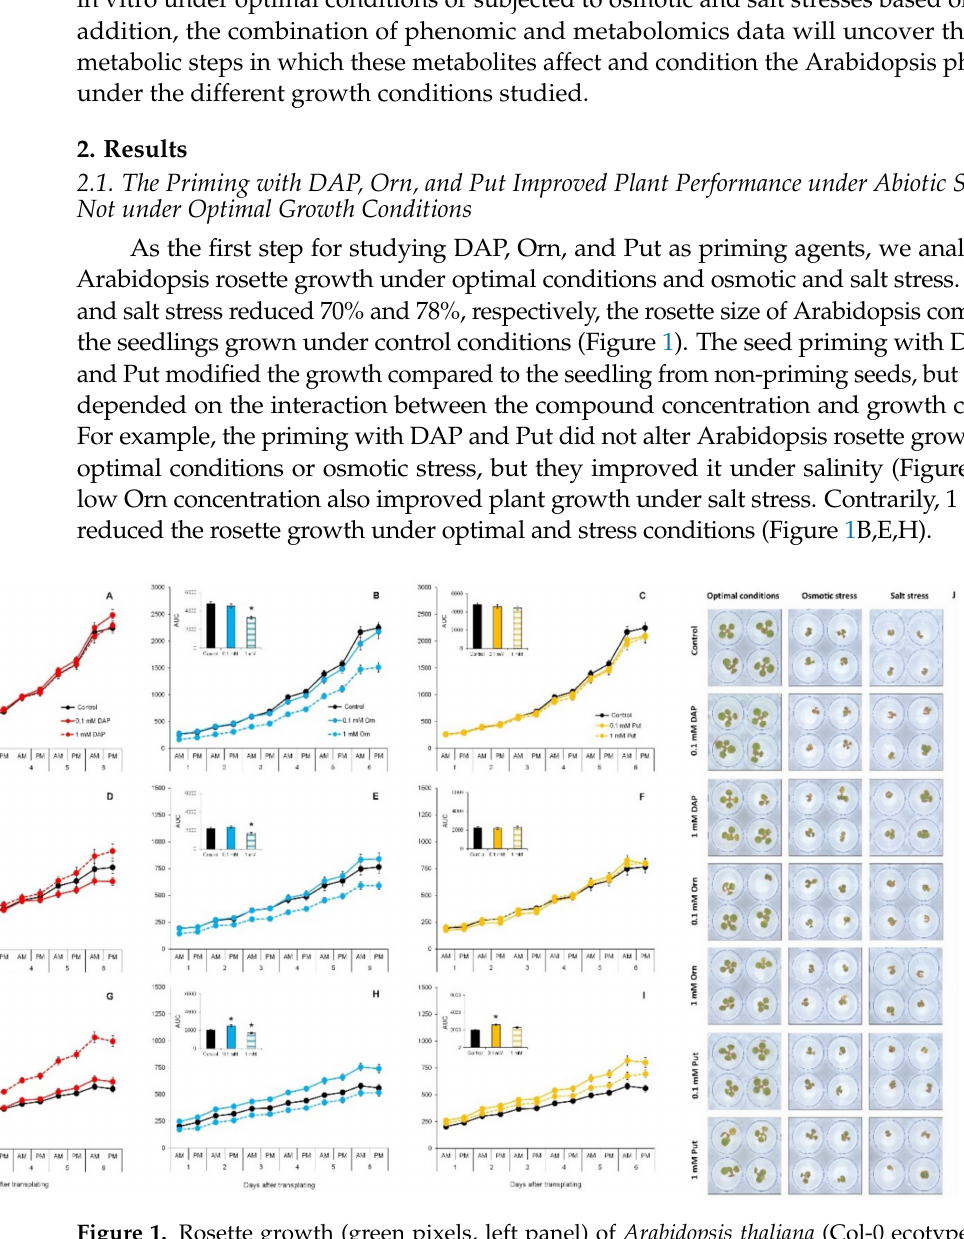
Figure 1. Rosette growth (green pixels, left panel) of Arabidopsis thaliana (Col-0 ecotype) primed with 1,3-diaminopropane (DAP), Ornithine (Orn), or Putrescine (Put) at two concentrations (0.1 or 1 mM) under optimal conditions ( A – C ), osmotic stress ( D – F ), and salt stress ( G – I ). RGB images ( J ) of the Arabidopsis seedlings 7 days after the transfer to the well-plates with different growth conditions. The corresponding area under the curve (AUC) for each growth curve was calculated and displayed in the bar chart. According to Kruskal–Wallis’ tests, asterisks show significant differences compared to the respective control treatment ( p < 0.05). Bars correspond to standard error. n = 48. Well diameter = 10.4